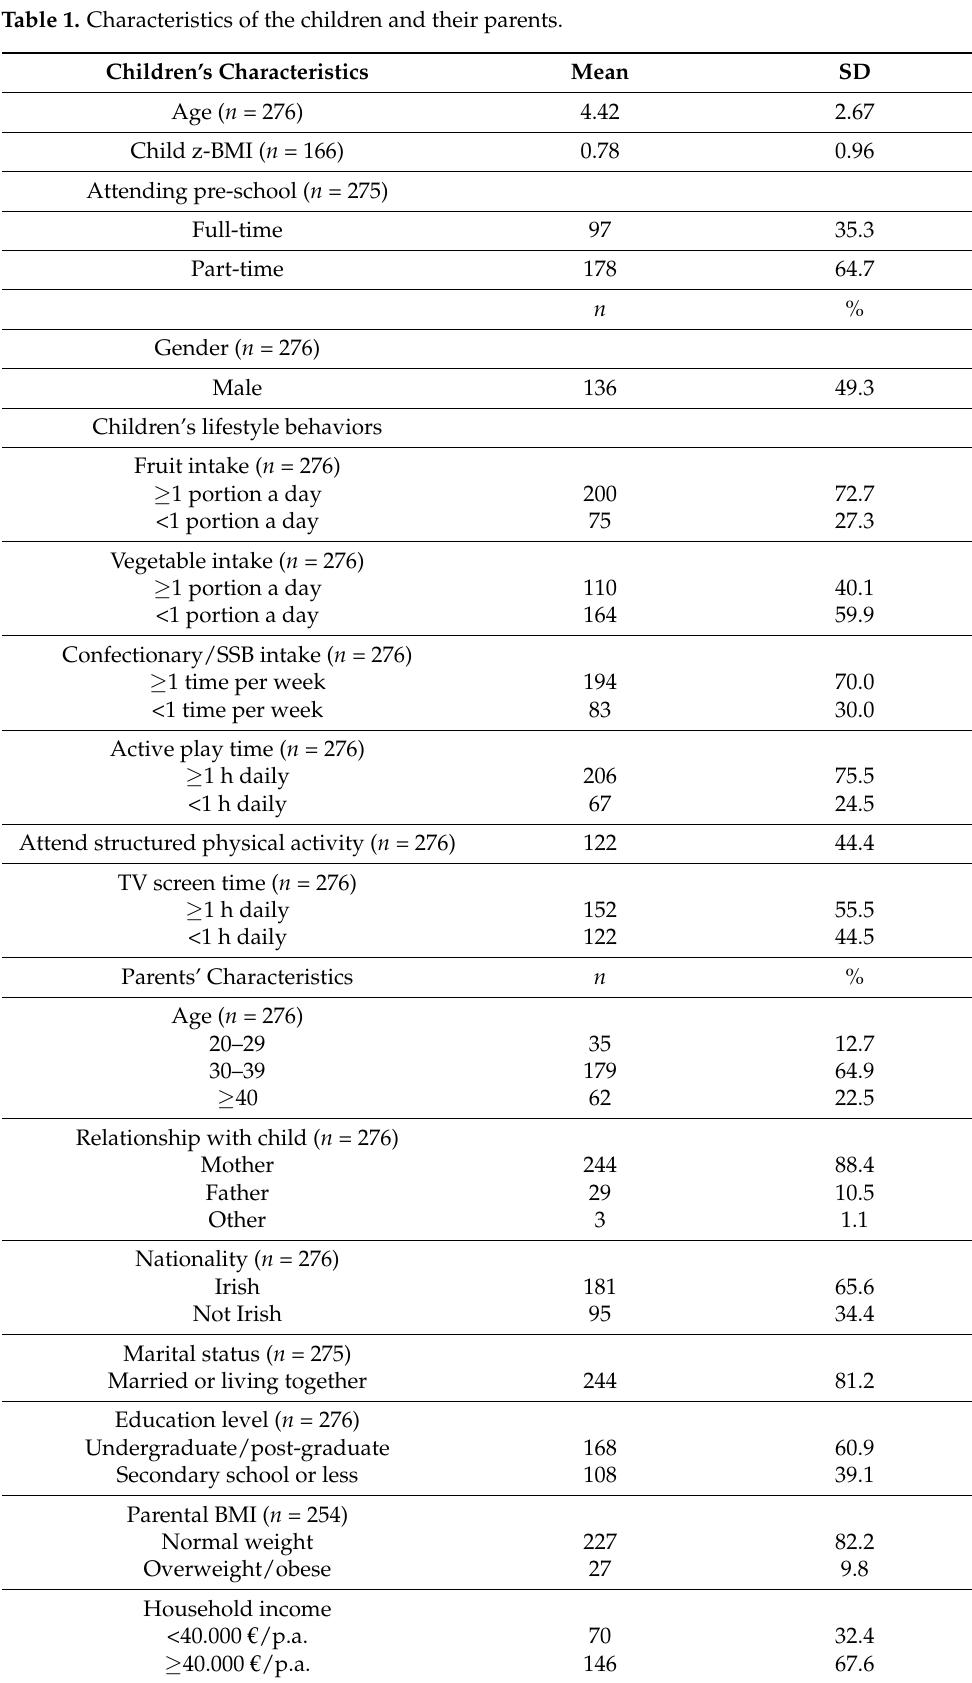
Table 1. Characteristics of the children and their